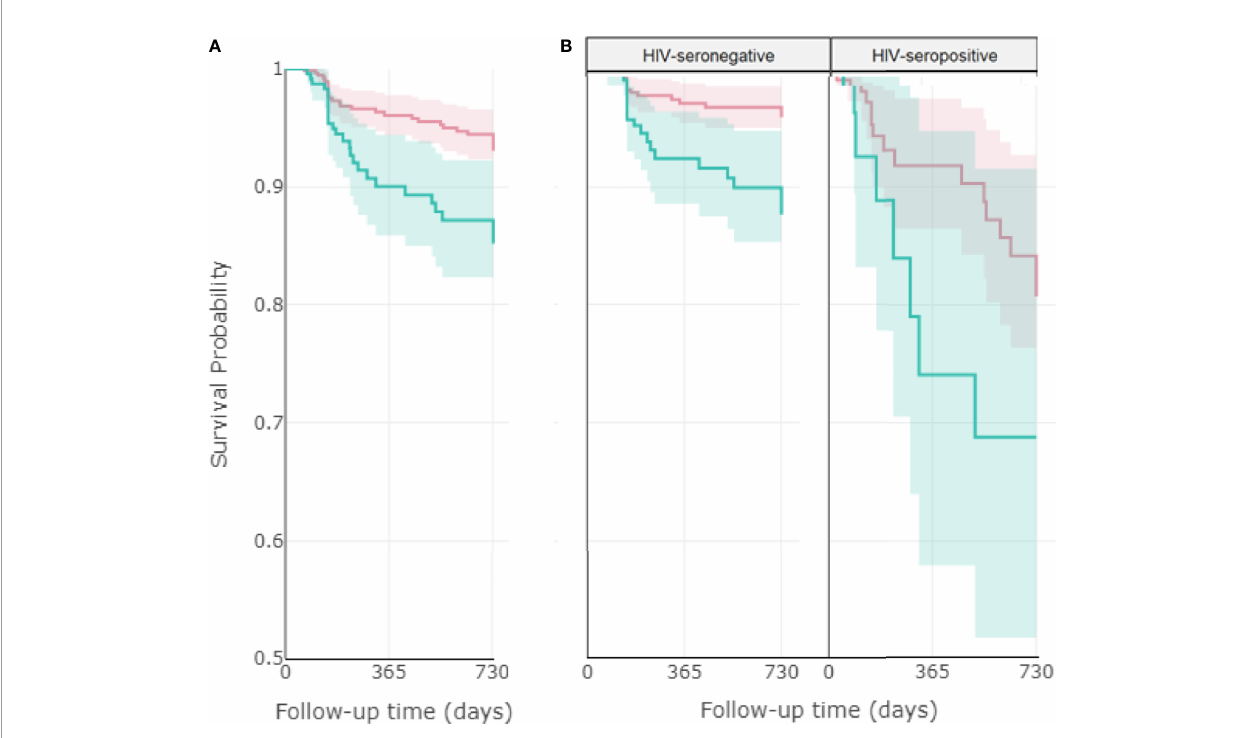
FIGURE 2 | Association between neutrophil count at baseline with time until unfavorable treatment outcome. Kaplan-Meier curves comparing the impact of higher (>7500/mm 3 ) and lower (<7500/mm 3 ) neutrophil count at baseline on the probability of facing a favorable outcome, considering (A) the total population (919 patients), (B) strati fi ed by HIV status (749 seronegative and 170 seropositive patients). The red line corresponds to low neutrophil count and the blue line corresponds to high neutrophil count, with their respective 95% con fi dence intervals. Favorable treatment: cure or treatment completion. Unfavorable treatment: death, failure, recurrence. Log rank p-values: 0.002 (A) , <0.001 ( B , left), 0.1 ( B ,